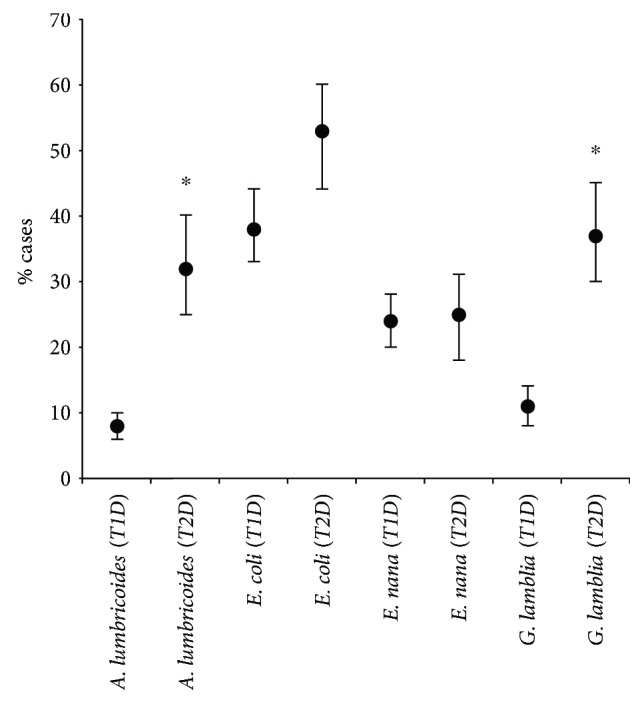
Estimated proportions and confidence intervals (lower and upper) of T1D and T2D patients infected with the most frequent parasites and commensals detected in the study, Federal District of Brazil, between 2011 and 2012. ∗p < 0.01 as statistically significant difference.